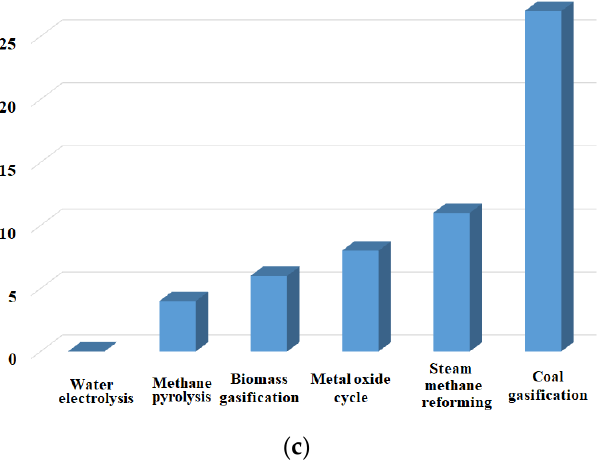
Figure 1. ( a ) Costs of hydrogen (EUR/t) produced by different technologies; ( b ) their energy efficiencies (%); and ( c ) carbon footprints (t CO2 /t H2 ) [26–32].